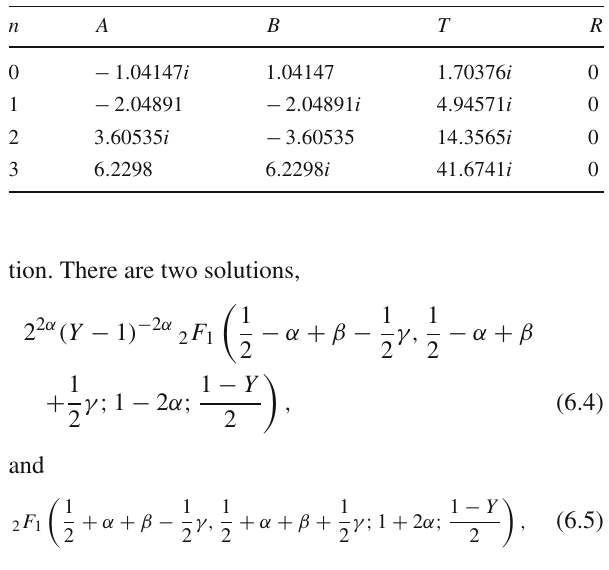
Table 3 Scattering coefficients for m (cid:2) = 0 scenario with r = a = q